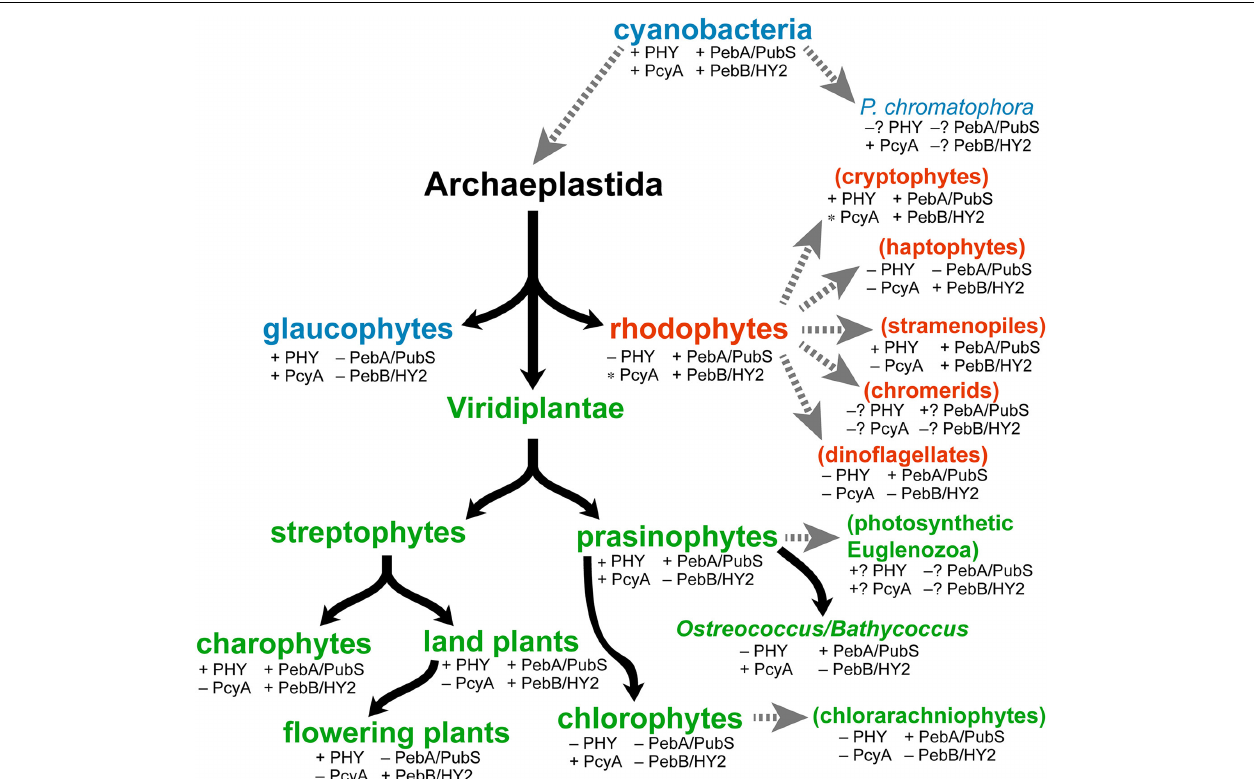
FIGURE 4 | Distribution of phytochromes and FDBRs in eukaryotic algae. Evolution of primary algae (Archaeplastidae) is shown, with glaucophyte (blue), rhodophyte (red) and Viridiplantae (green) lineages. We define subsequent evolution of the Viridiplantae with an initial split into streptophytes and prasinophytes. The streptophytes comprise modern charophytes and land plants (embryophytes). Modern charophyte and prasinophyte algae are paraphyletic, with land plants and chlorophyte algae descending from charophytes and prasinophytes, respectively (Worden et al., 2009; Timme et al., 2012; Duanmu et al., 2014). Subsequent endosymbioses (dashed gray arrows) gave rise to secondary algae (parentheses), which are color-coded to indicate the Archaeplastida lineage that was assimilated. Tertiary endosymbioses of diatoms by dinoflagellates are not shown. Distribution of phytochromes was assessed by performing